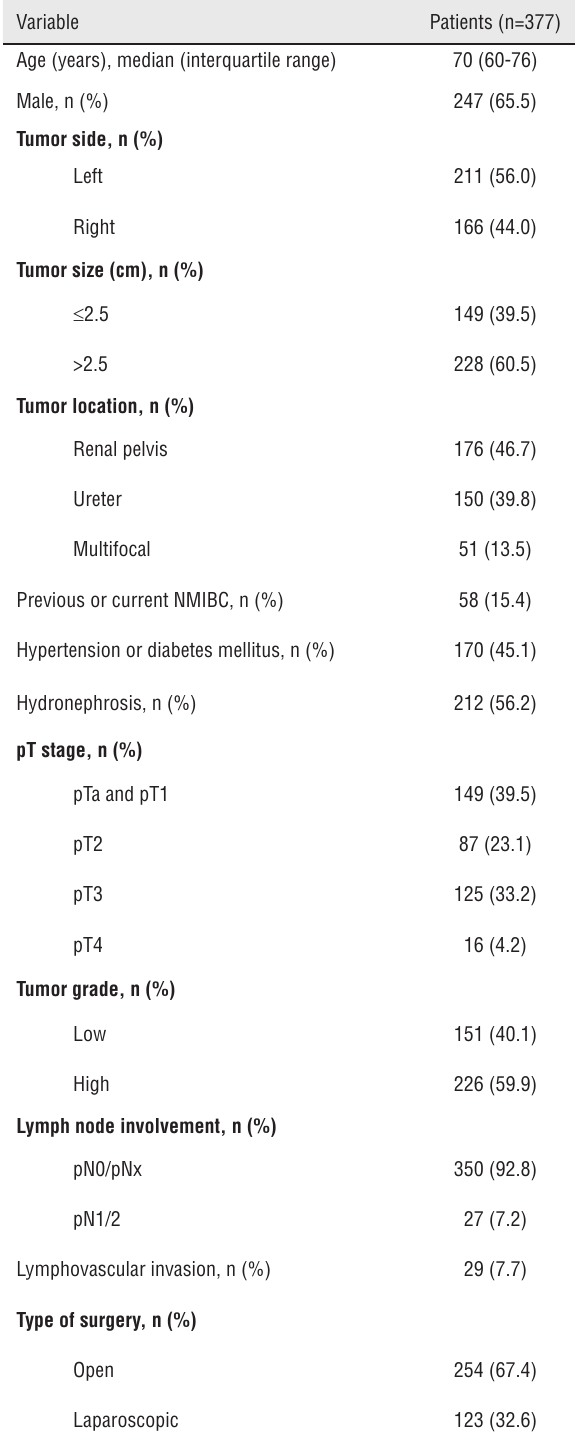
Table 1 - Clinical characteristics of patients with upper tract urothelial